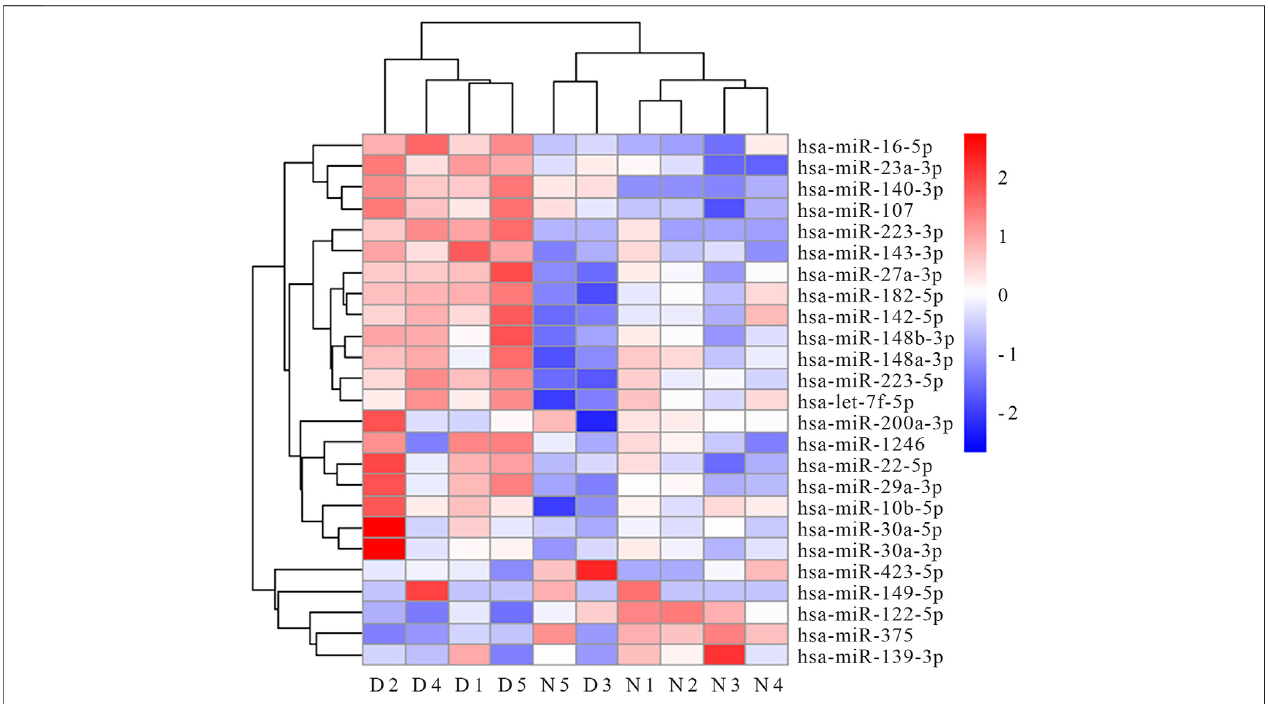
FIGURE 1 | Heat map of top 25 miRNAs differentially expressed in serum MV of AIS patients and healthy controls (N1~N5 represent healthy controls, D1~D5 represent AIS patients).